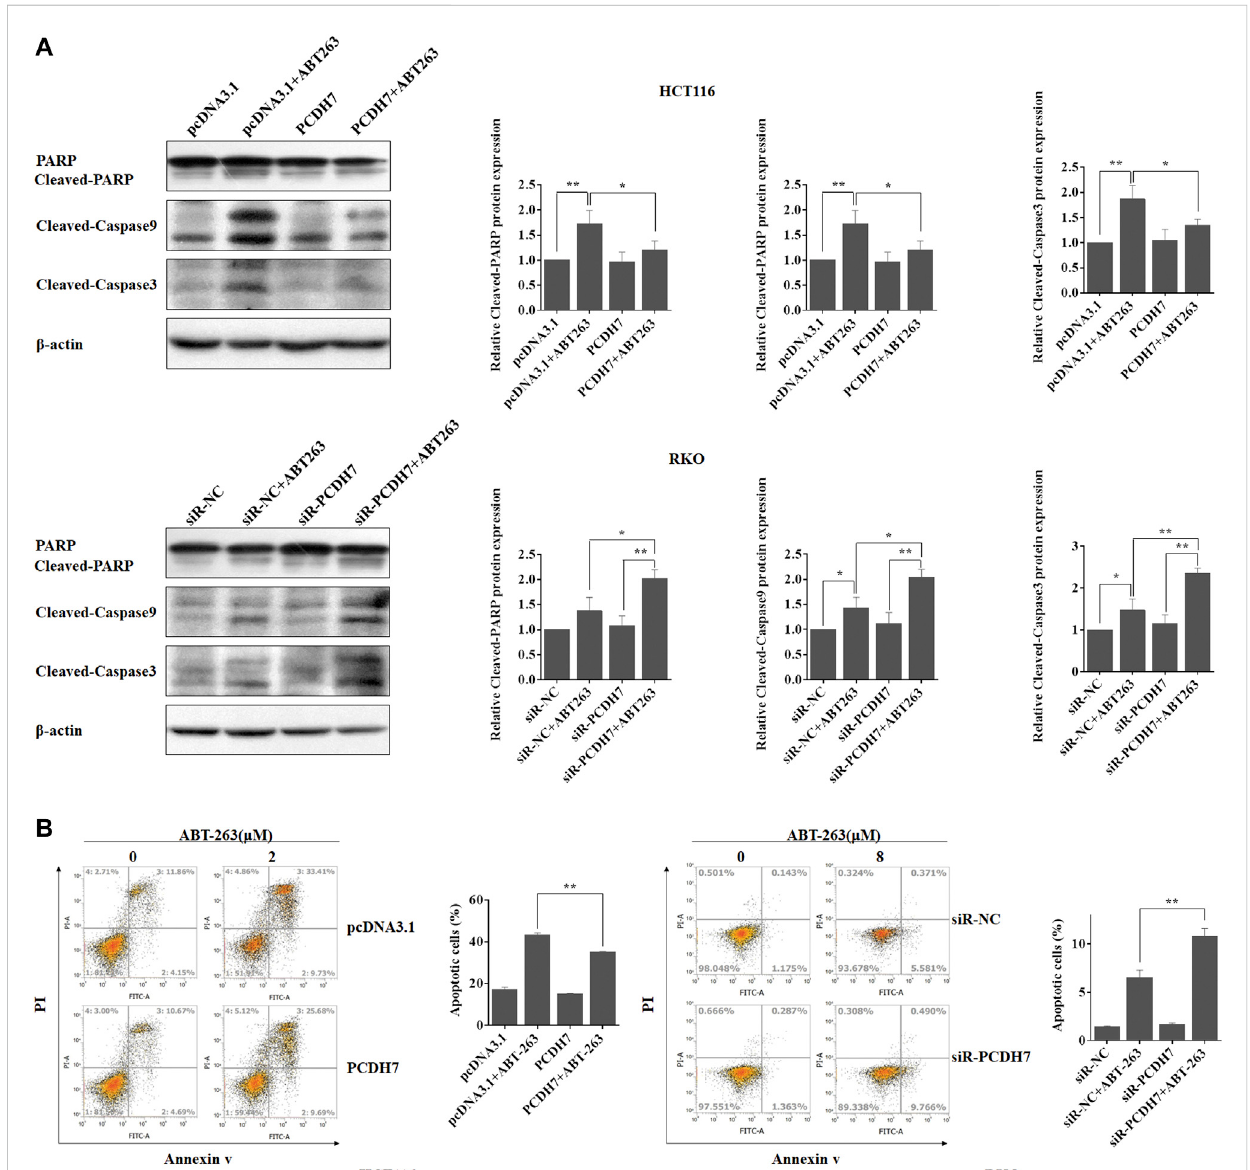
PCDH7 promoted drug resistance to CRC cells to ABT-263 by repressing apoptosis. (A) The cleavage of caspase 3, caspase 9, and PAPR was detected by western blot experiment in HCT116 and RKO cells treated with ABT-263 under PCDH7 overexpression or not, respectively. Representative data was shown. (B) HCT116 and RKO cells were treated with ABT-263 under PCDH7 overexpression or silencing, respectively. Apoptosis was examined byusing fl ow cytometry with Annexin V-FITC/PI staining.Data are presented as mean ± SD for threeseparateexperiments. * p < 0.05;** p < 0.01. vs.